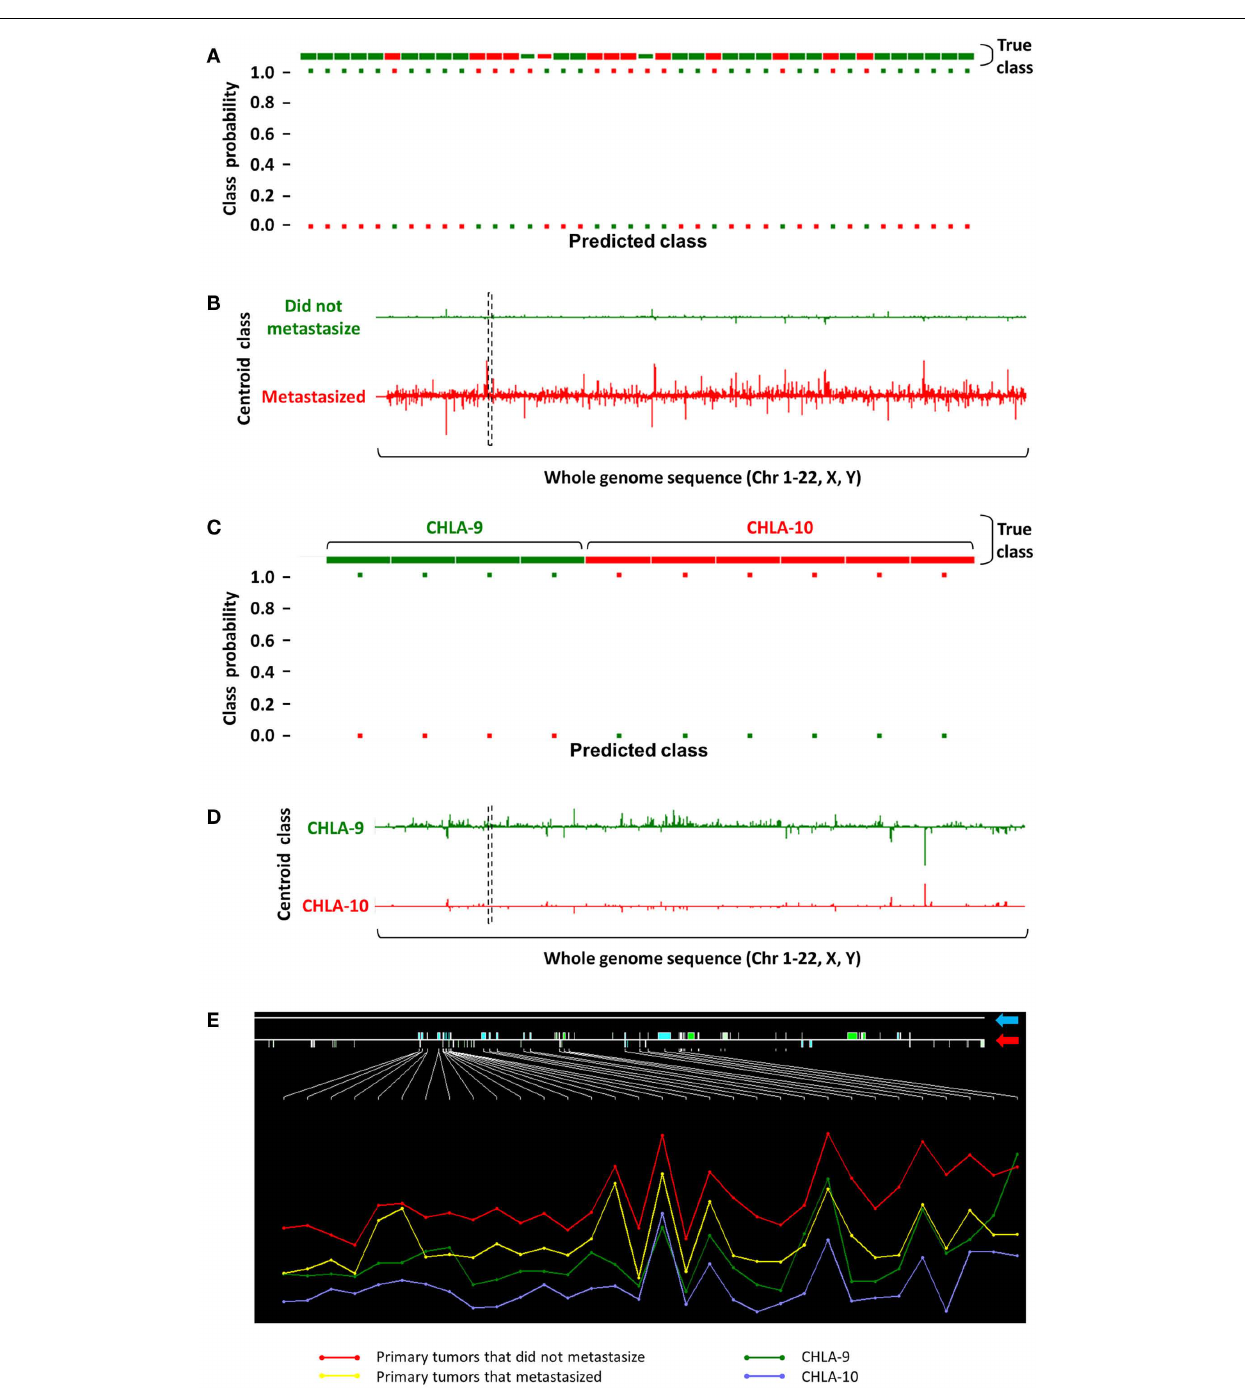
classification accuracy at Δ = 6.0. (D) Comparing the PSR profiles between both nearest shrunken centroid models resulted in the identification of a common 26kb intergenic non-coding transcript [dashed black box in (B) and (D) ]. (E) A zoomed in inspection of this genomic segment (blue arrow points to the RefSeq annotation; red arrow indicates positions of PSRs across the region) showed that the transcript was highly expressed in tumors that never metastasized, moderately expressed in tumors that eventually metastasized and CHLA-9, and showed low expression in CHLA-10. Height of the Y -axis corresponds to the logarithm of PSR expression levels, and samples are aggregated into their respective tumor